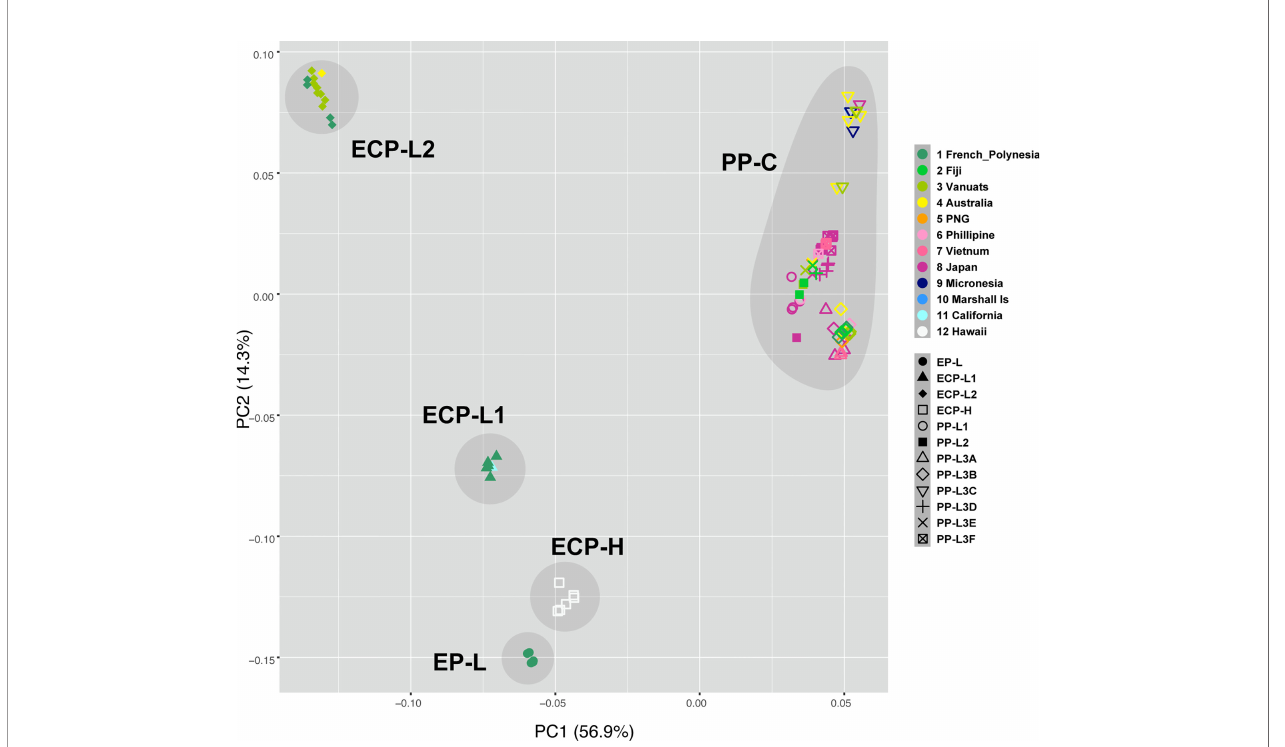
FIGURE 4 | Principle Component Analysis identi fi es fi ve COTS populations, PP-C, and four lineages of ECP-C, EP-L, ECP-L1, ECP-L2, and ECP-H. PP-C contains COTS collected from all the Pan Paci fi c countries except for USA, suggesting that these populations are expanded from a common ancestor population. Color codes are shown at the right